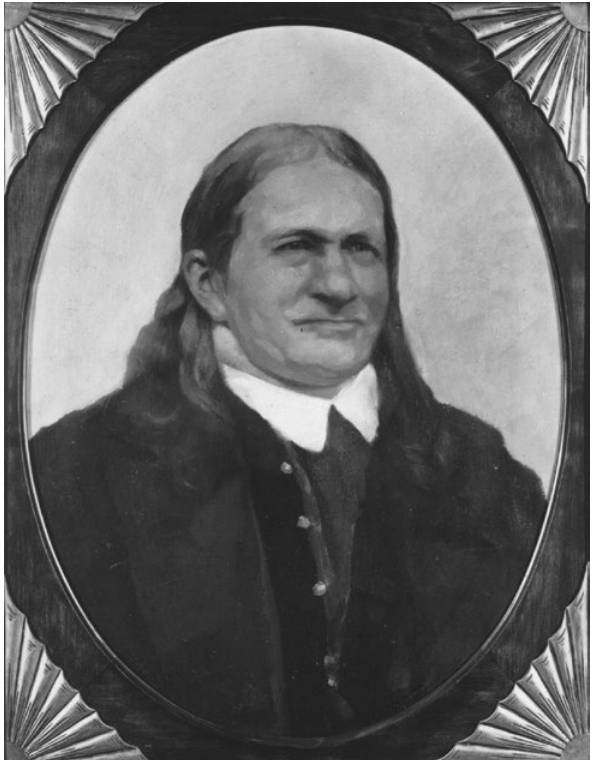
Figure 4. Friedlieb Ferdinand Runge (1794-1867). [Edgar Fahs Smith Memorial Collection. Kislak Center for Special Collections, Rare Books and Manuscripts. University of